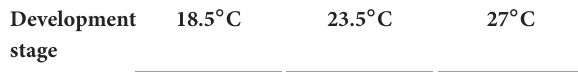
TABLE 5 Predation rate for the stage of Orius strigicollis survived ( P j ) fed on Frankliniella occidentalis at different temperatures.